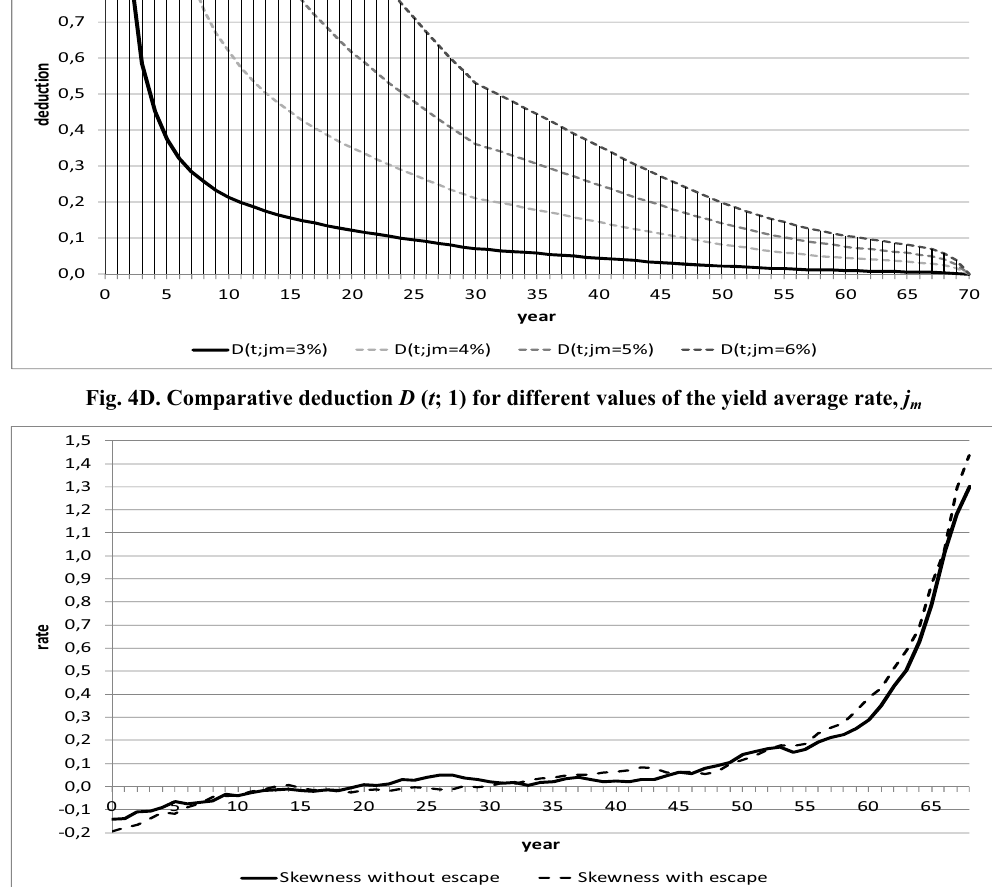
(cid:5) U evaluated in presence and in absence of contract t